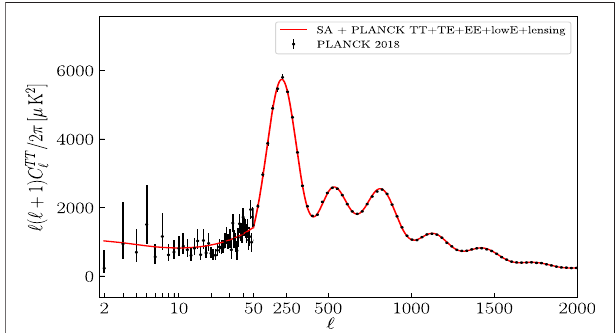
FIGURE 1 | The TT-power spectrum. The (red) continuous curve is the theoretical prediction from standard ansatz while the (black) dots with error bars represent the measurements of the PLANCK team reported in 2018. Thereisexcellentagreementbetweentheoryandobservationsfor ℓ > 50 but the observed power is suppressed relative to the theoretical prediction for ℓ ( 30. As usual, the horizontal axis uses a logarithmic scale for ℓ ( 50 but a linear scale for ℓ a